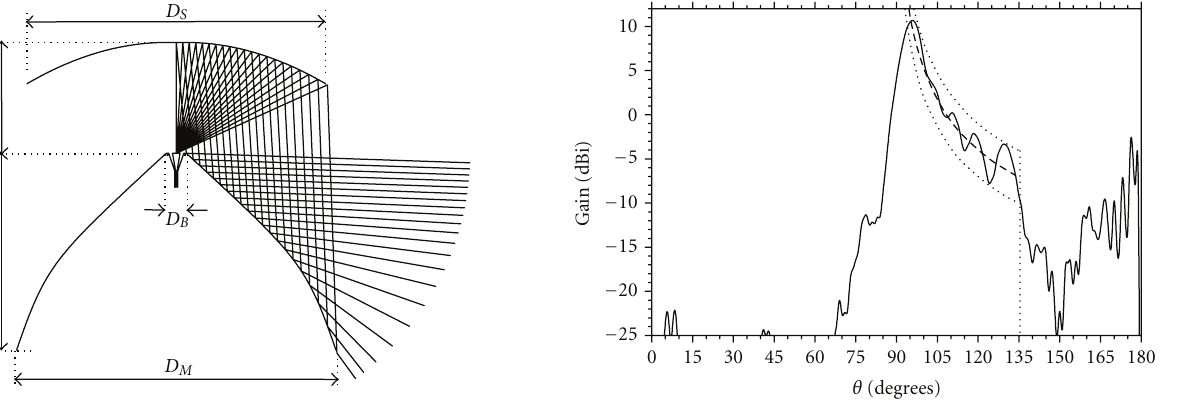
Figure 4: MoM radiation pattern in the elevation plane of the OADC antenna of Case I (solid line), together with the cosecant- squared pattern (dashed line) and its ± 3 dB limits (dotted lines).